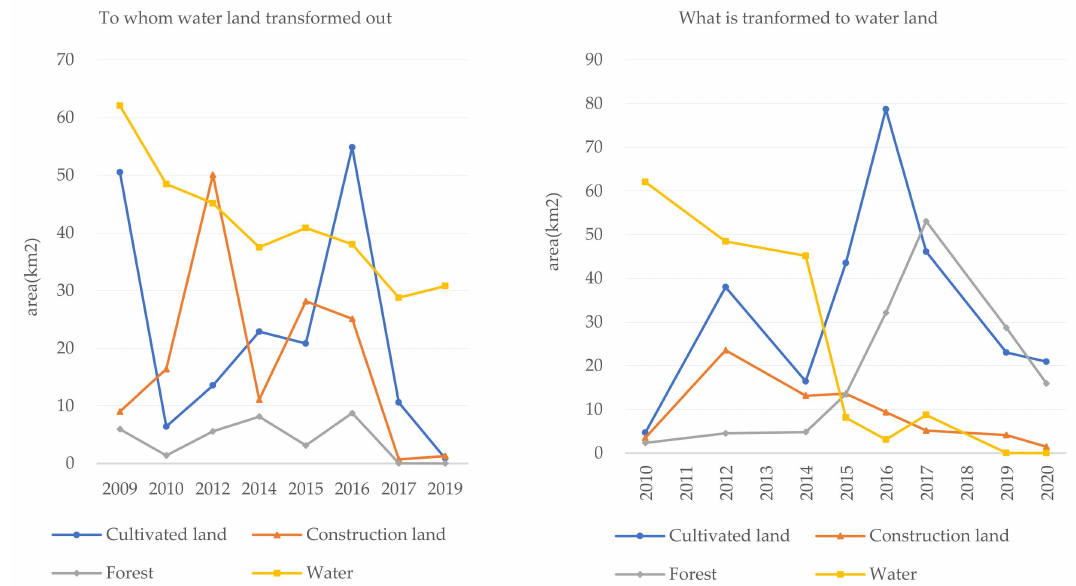
Figure 15. Changes of water land area in the studied